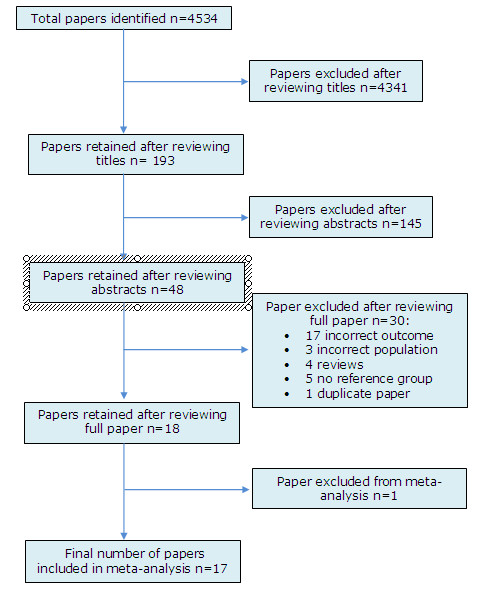
Flow diagram of included and excluded studies.